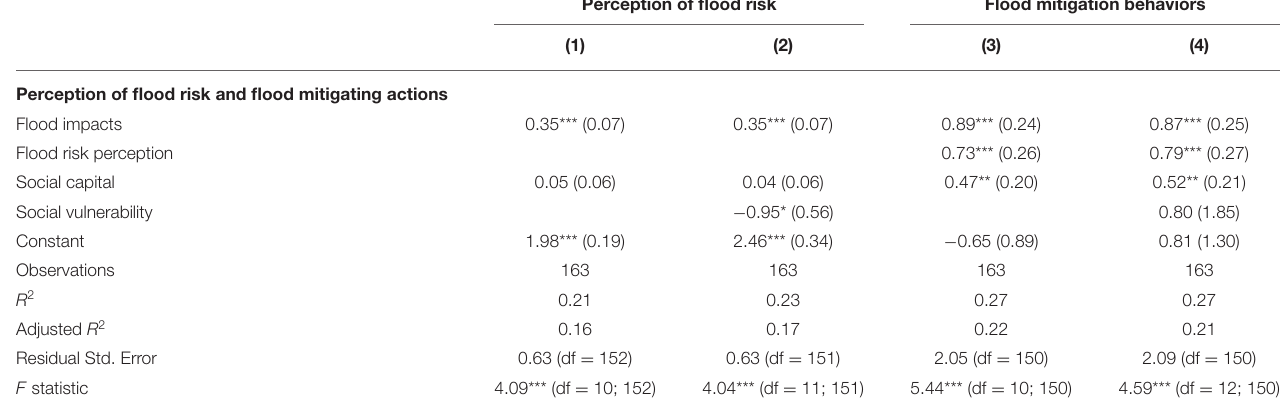
TABLE 4 | OLS regression results.